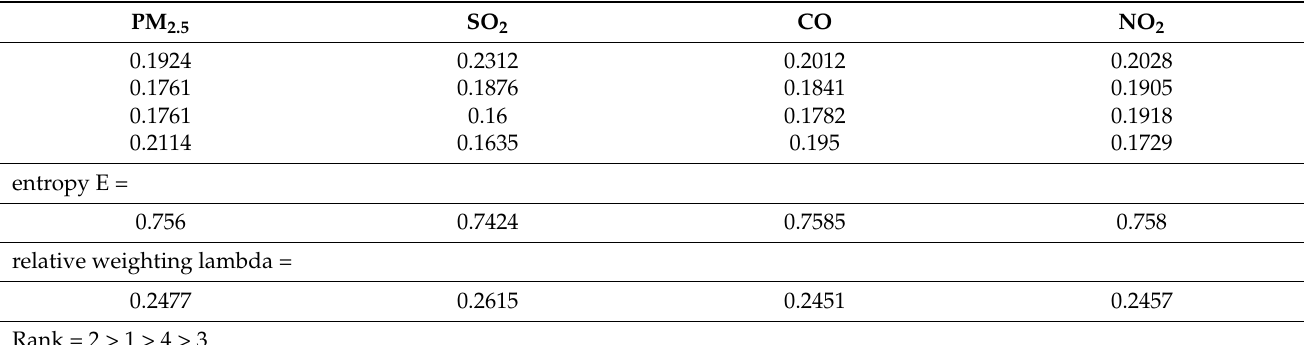
Table 8. Weighted values of each factor using grey